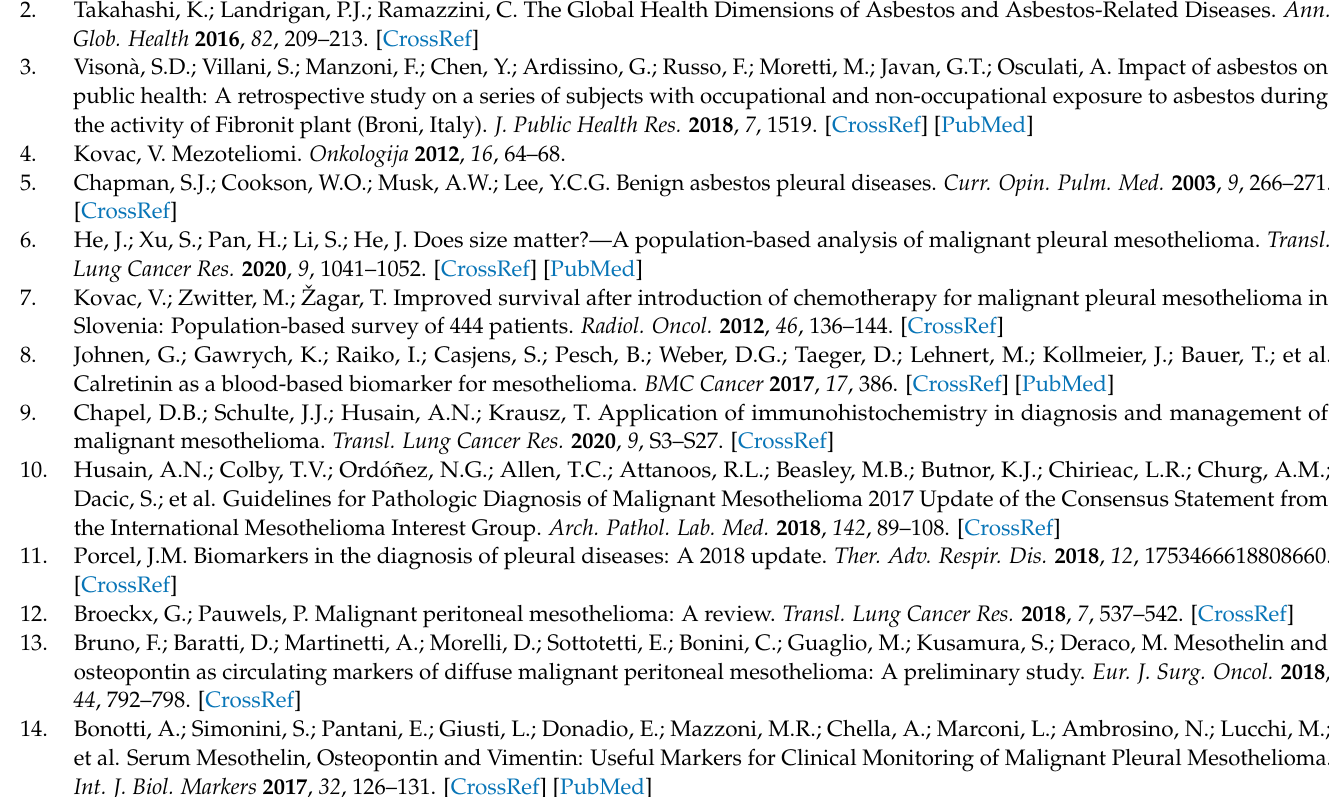
Table S2: data on asbestos exposure among subjects without malignant mesothelioma, occupationally exposed to asbestos, Table S3: association of asbestos exposure with calretinin levels among subjects without malignant mesothelioma, occupationally exposed to asbestos, Table S4: association of asbestos exposure with calretinin levels among patients with malignant